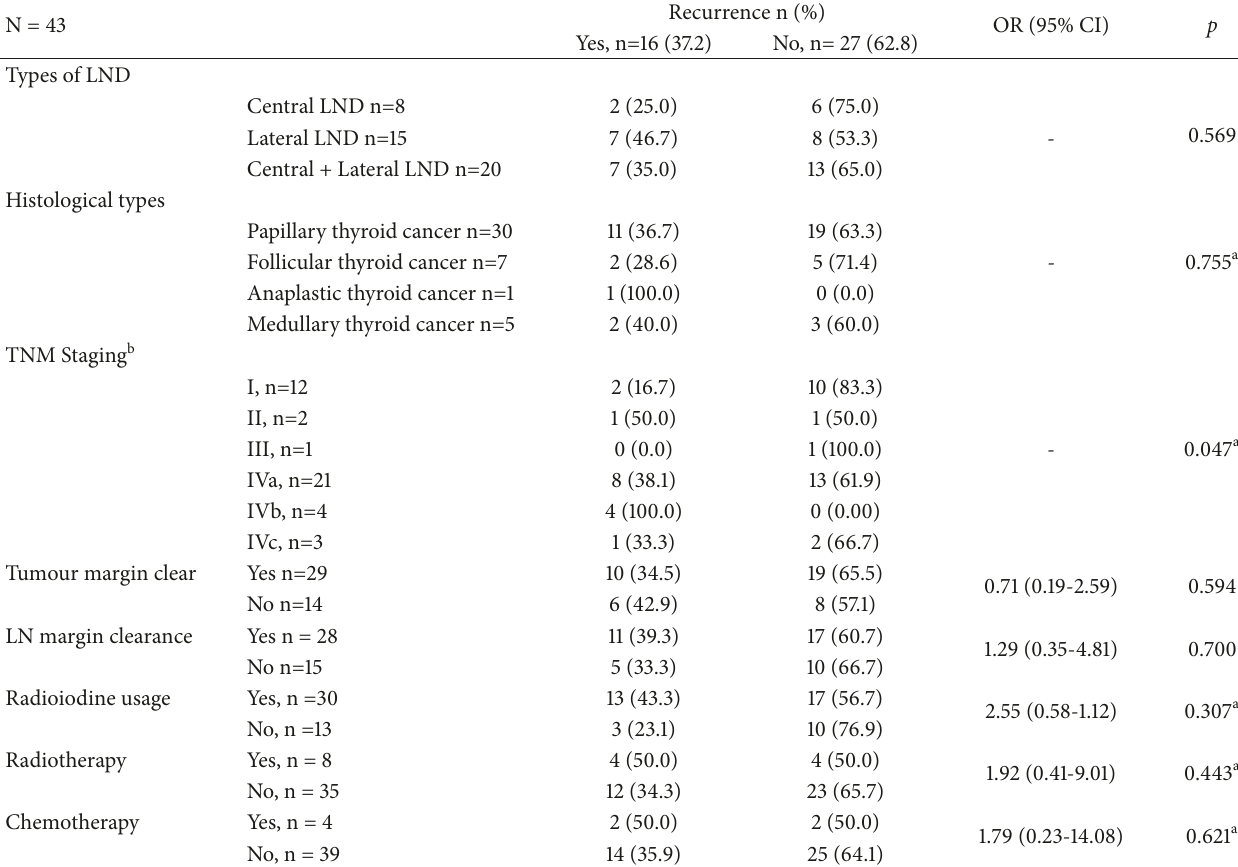
Table 2: Subgroup analysis of those who had recurrence in the 3-year follow-up